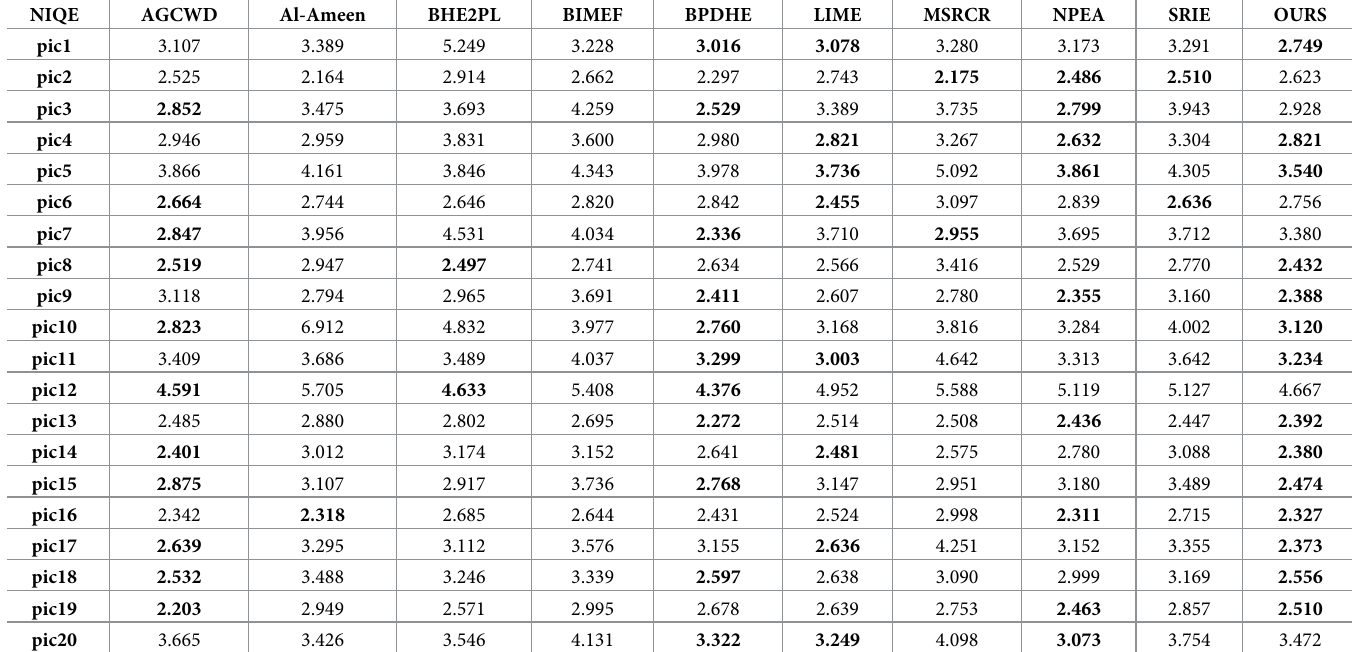
Table 17. NIQE values of 20 random images of MIT-5K.